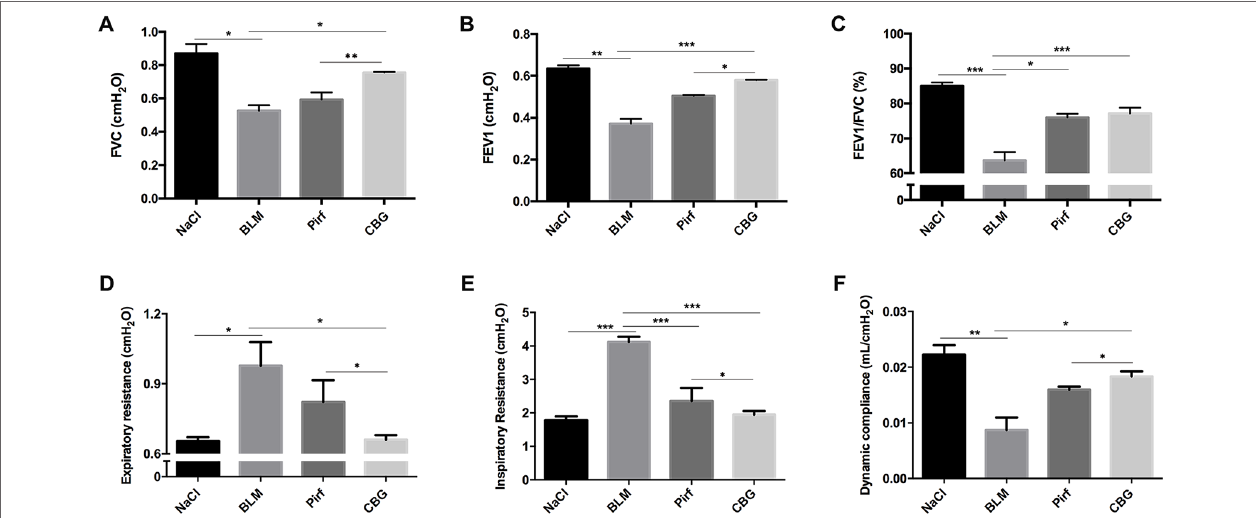
FIGURE 6 | Cinobufagin improves pulmonary function in BLM-treated mice. Two weeks after BLM administration, pulmonary function of mice was determined. Pulmonary function parameters, including (A) Forced vital capacity (FVC), (B) Forced expiratory volume in one second (FEV1), (C) Forced expiratory volume in one